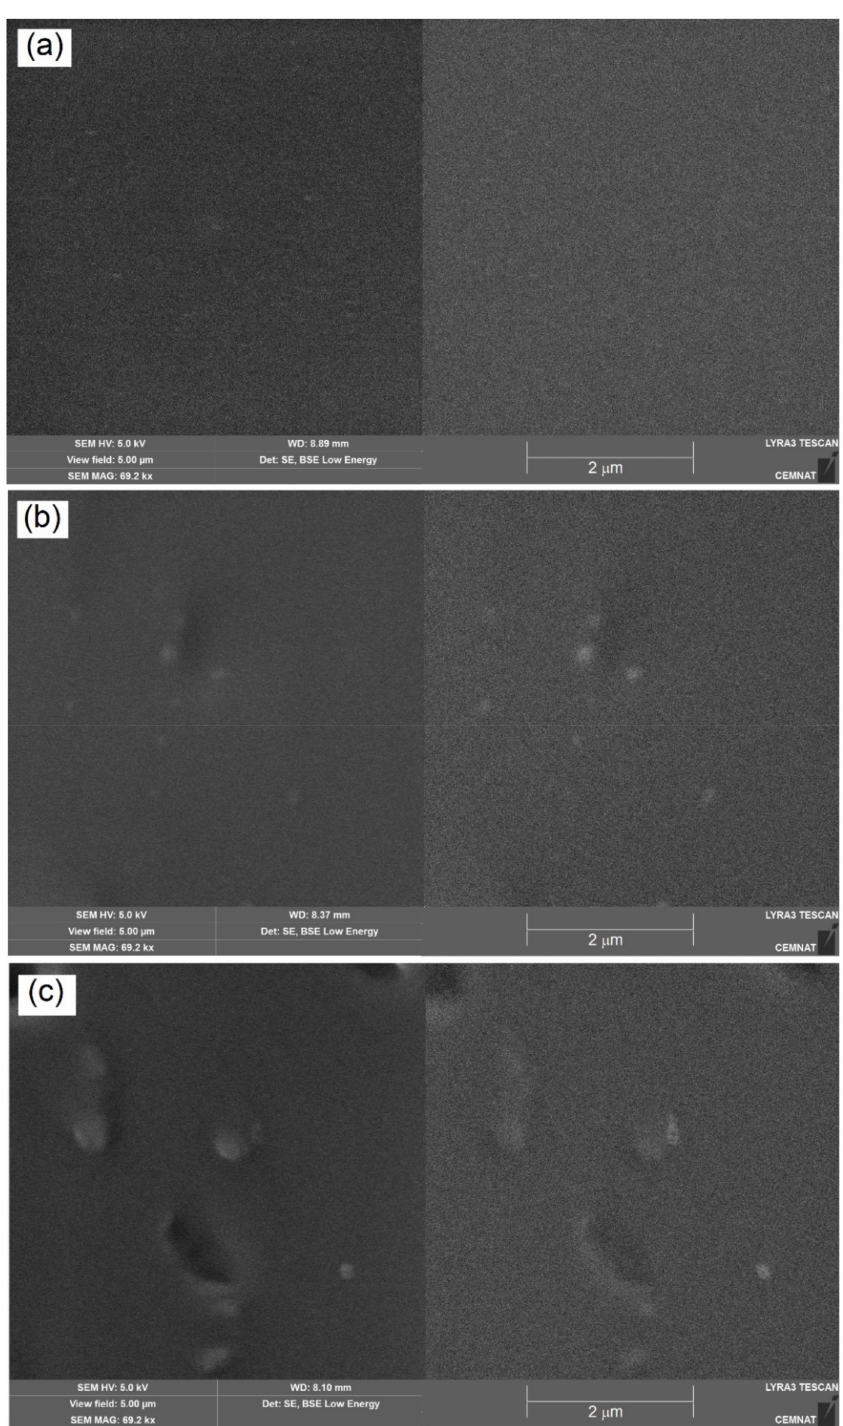
Figure 4. SEM photographs of cryofractures of latex coatings taken in secondary electron (left) and backscattered electron mode (right): ( a ) blank sample D 4 ; ( b ) sample D 4_ZnO ; ( c ) sample H 4_ZnO . The scalebar applies to both SE and BSE